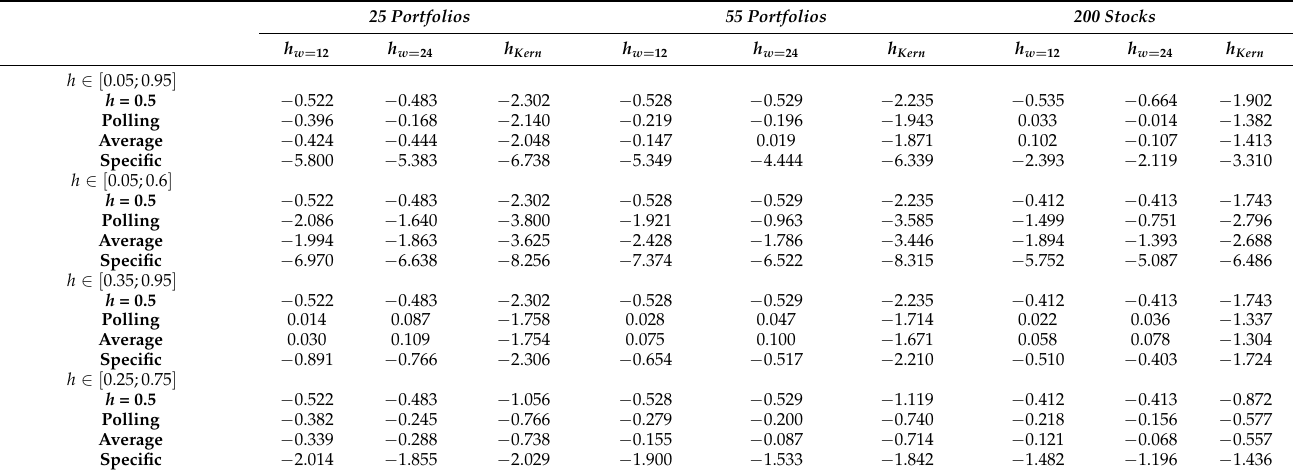
Table A1. Percentage reduction in RMSEs for different bandwidth parameter